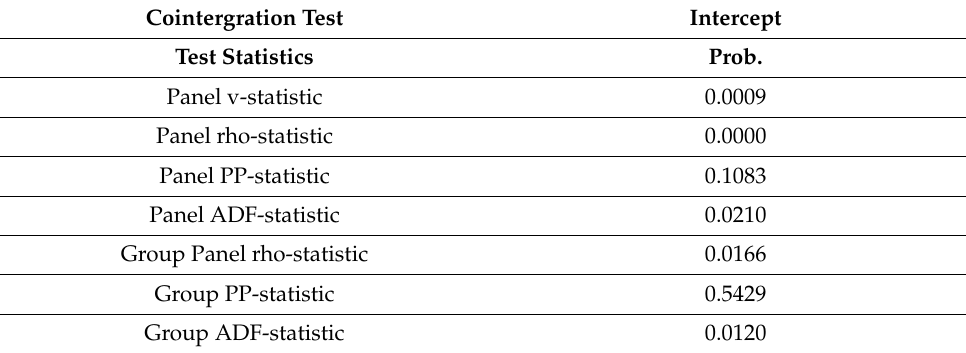
Table 5. Pedroni cointegration